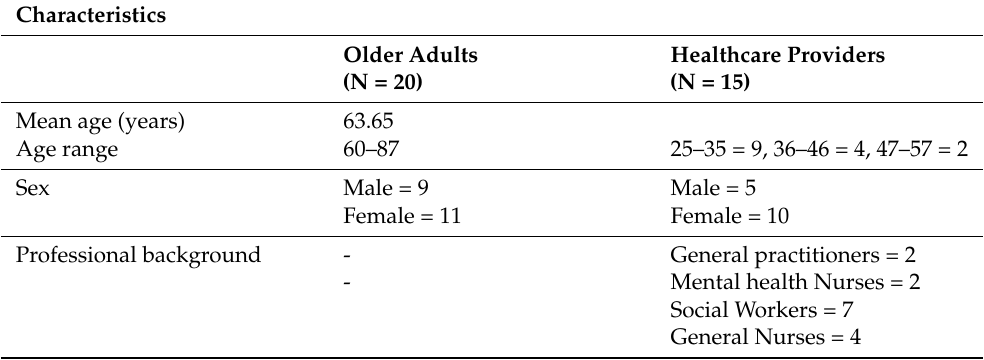
Table 1. Participant